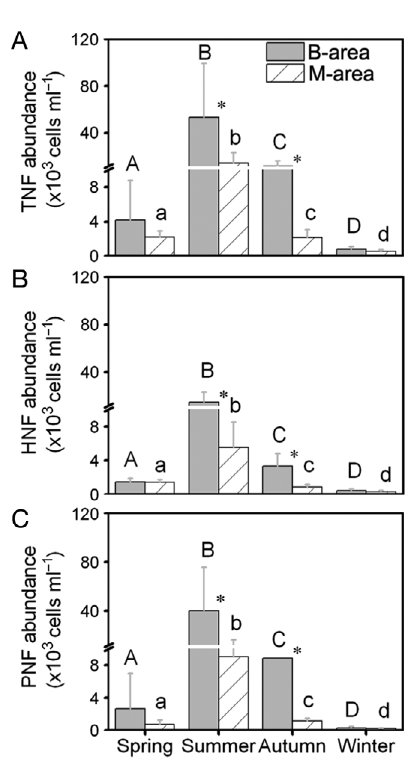
Fig. 4. Mean (+SD) abundance of (A) total nanoflagellate (TNF), (B) heterotrophic nanoflagellate (HNF) and (C) pig- mented nanoflagellate (PNF) in the B-area and M-area (see Fig. 1). *Significant difference (p < 0.05, t -test) between the 2 areas in the same season. Different uppercase and lower- case letters indicate significant (p < 0.05) differences among 4 seasons for B-area and M-area, respectively